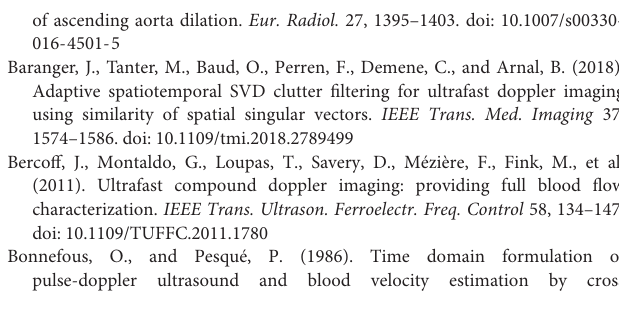
FIGURE S1 | Longitudinal section of a common carotid artery with ultrafast ultrasound B-mode imaging. The segmentations of the anterior (blue line) and posterior (red line) walls are indicated in the picture. FIGURE S2 | Correlations of the wall shear stress (WSS) parameters ( Y -axis) with age ( X -axis): Maximal WSS (A) and time-average WSS (B) , for BAV patients (red) and controls (blue). BAV: bicuspid aortic valve. Pearson’s coefficients square ( R 2 ) and P -values for each correlation line are presented. TABLE S1 | Linear correlations of maximal wall shear stress (WSS) and time average WSS, with age. VIDEO S1 | Ultrafast ultrasound imaging of a common carotid artery. Representation of the tissue Doppler data (color scale). The propagation of the pulse wave components (PWV1 and PWV2) is notified on the ECG